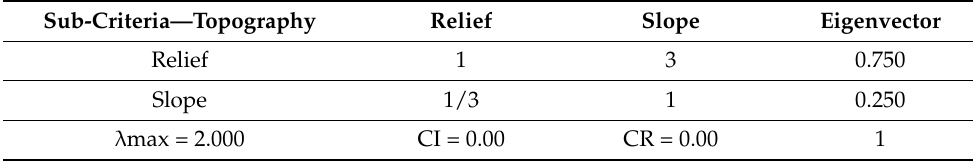
Table 5. Pair-wise comparison matrix of the sub-criteria for